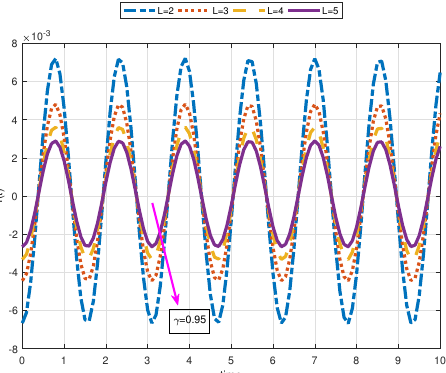
Figure 12. This graph corresponds to solution Equation (36) including oscillatory source for various values of α and ρ and γ in order to see the effect of L when C = 47 F, e 0 = 50 V, θ = 60 Hz, and I ( 0 ) =